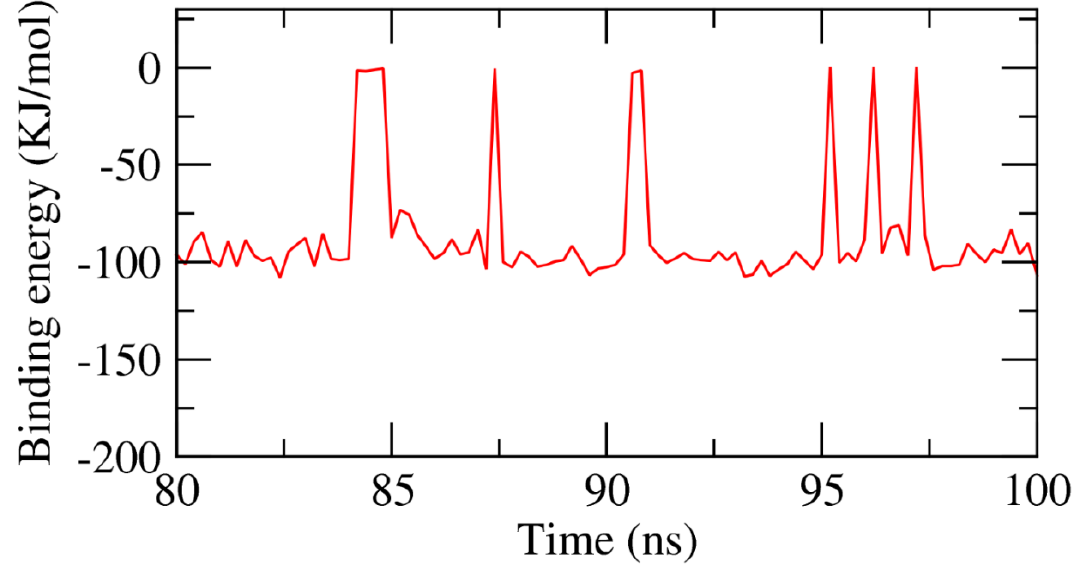
Figure 8. MM-PBSA study of the resveratrol –β -CD complex.